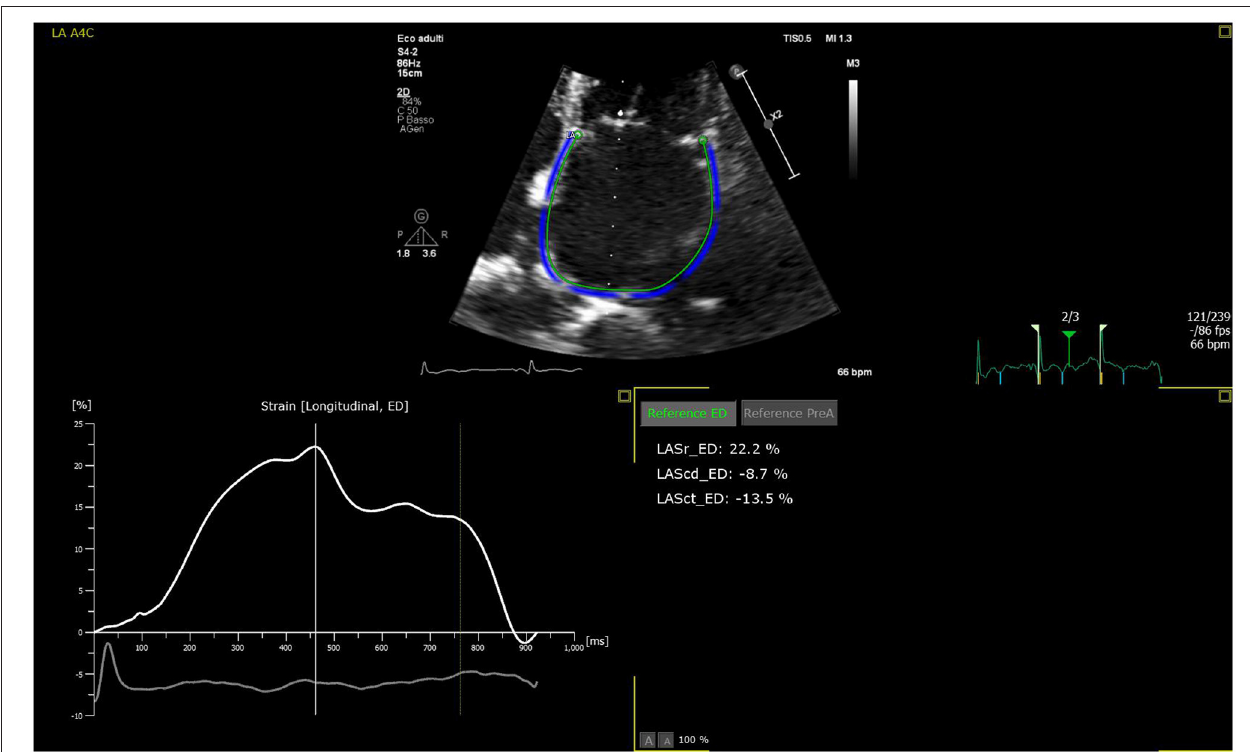
FIGURE 2 | LA strain curve with R-R gating method in apical four-chamber view with zoom-in focus. The patient is an 83-year-old female with chronic heart failure. The patient is in sinus rhythm with reservoir function reduced. Zoomed image is used to increase the frame rate to enhance strain analysis